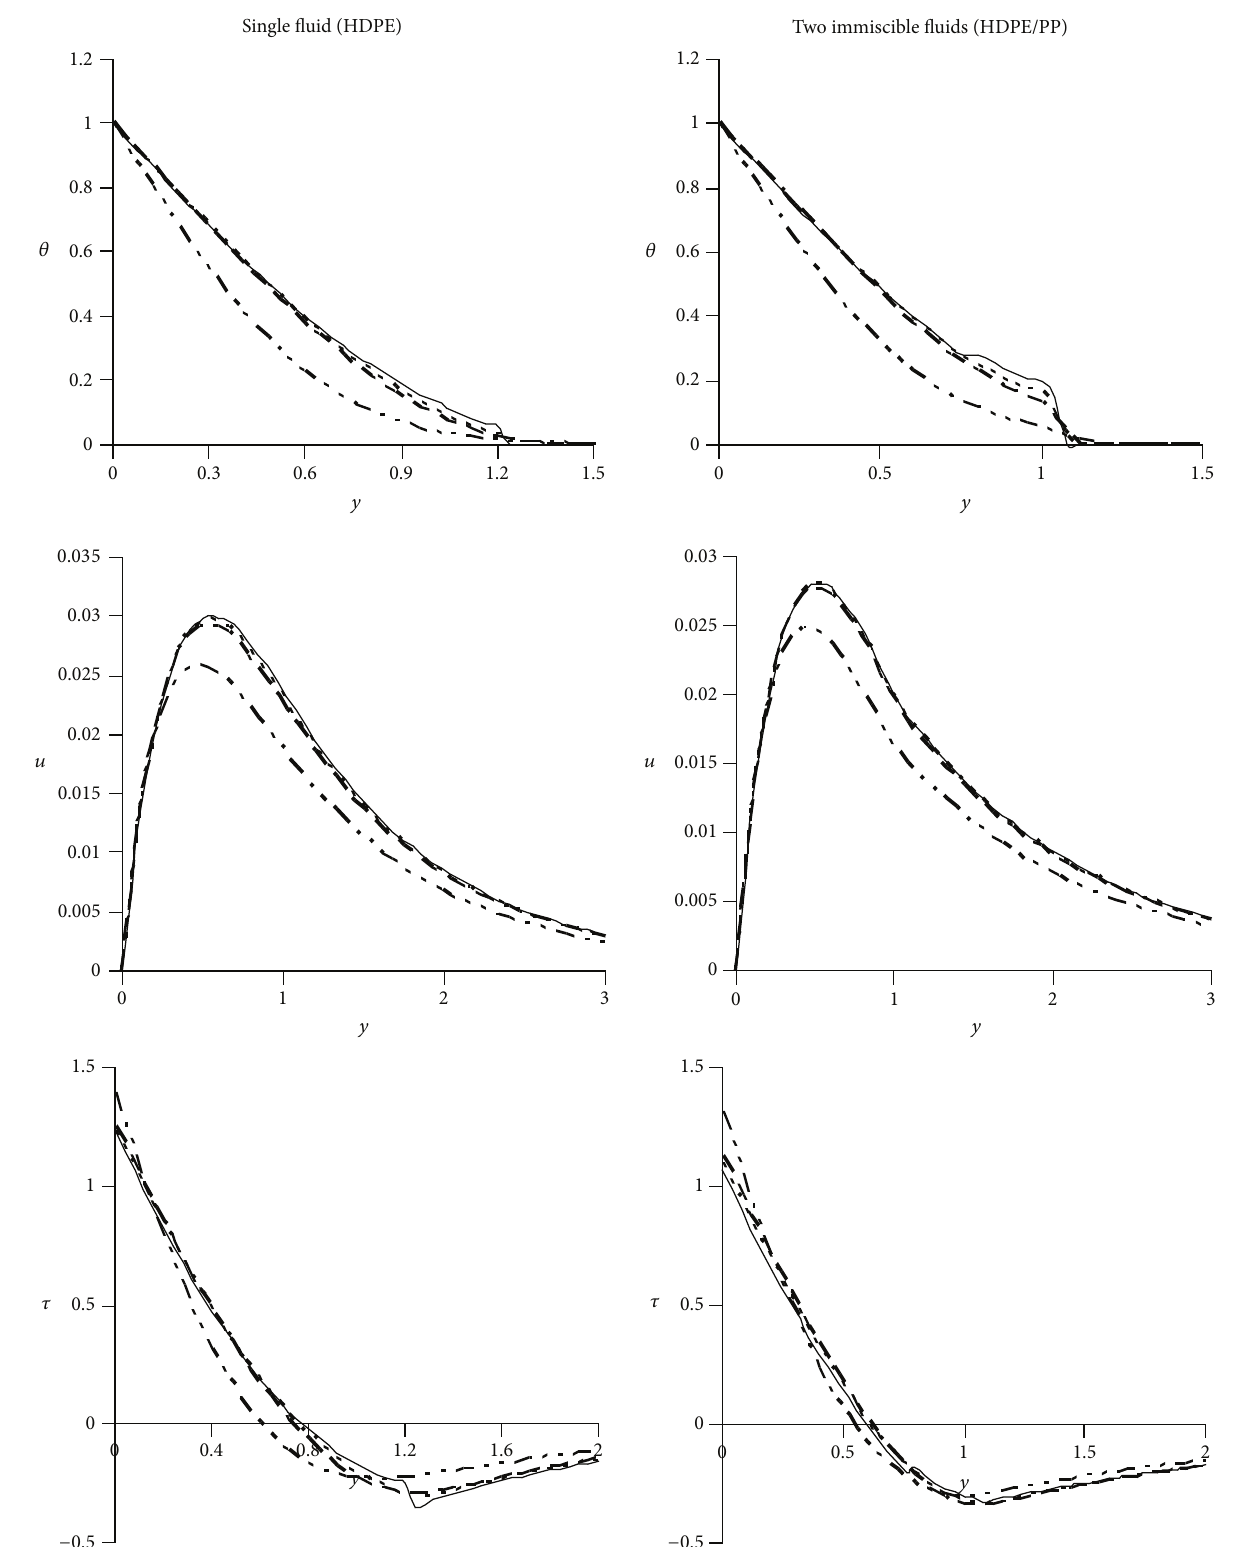
Figure 2: Temperature, velocity, and stress distribution for 𝛼 2 = 𝛽 1 = 𝛽 2 = 1 , 𝑡 = 0.09 , and 𝛼 1 = { 0.0 (– ⋅ ⋅ –); 0.8 (–– –); 0.9 ( ⋅ ⋅ ⋅ ); 1.0 (— )}